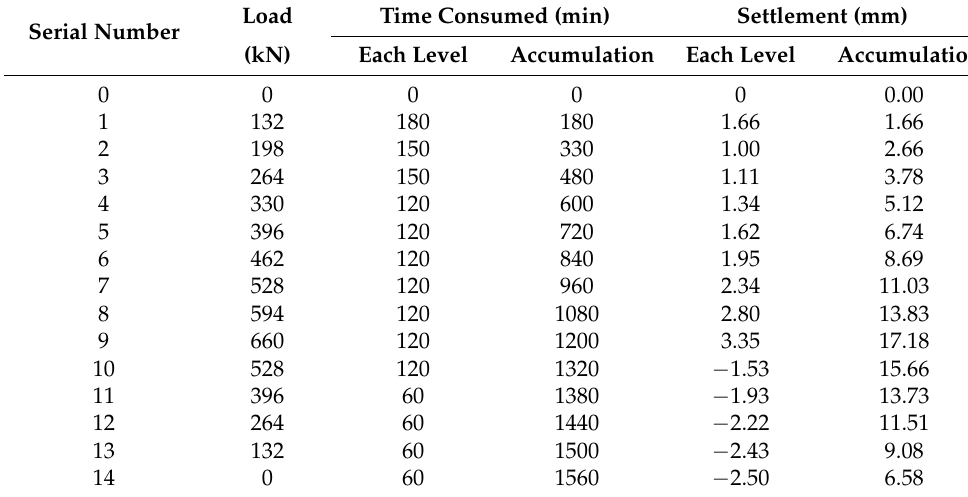
Table 2. Settlement result table of No. 2-X2# pile under graded loading. Load Serial Number